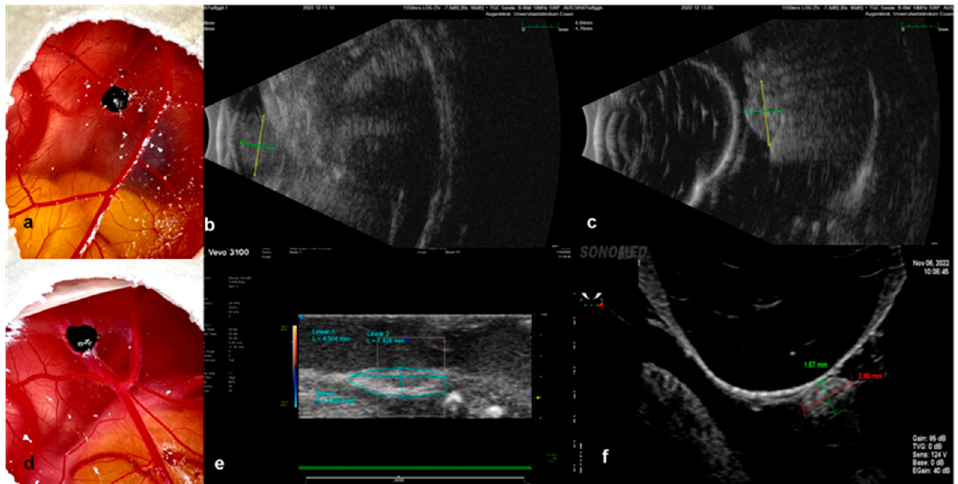
Figure 7. Ultrasound as a monitoring instrument to evaluate the growth of the implanted tumors in the CAM Model. ( a – c ) Examples of the evaluation of size with the B-Scan ophthalmic ultrasound, where the tumor, implanted with Matrigel, was measured directly with the 10 MHz probe; it pre- sents as a hyperechoic ellipsoid mass on the surface of the CAM, ( b ) and subsequently with the latex fingerstall filled with water for the adjustment of depth as well as for the acquisition of images of higher definition. ( c – f ) Examples of the evaluation of graft size via a preclinical imaging system with ultra-high-frequency ultrasound ( e ) and ultrasound biomicroscopy ( f ) after implantation without